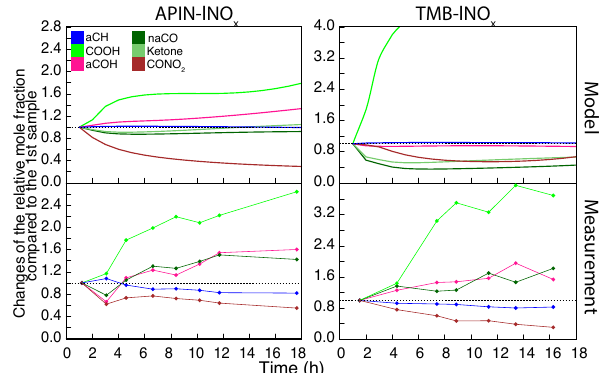
Figure 2. Comparison of the changes of the relative mole frac- tion compared to the first sample for COOH, COH, CO, aCH, and CONO 2 of the aerosol phase measured by Sax et al. (2005) and modeled in this work for APIN-lNO x and TMB-lNO x . For a cho- sen FG, the changes of the relative mole fraction compared to the first sample are calculated as the ratio between the relative mole fraction at the chosen time and the relative mole fraction at 1h. naCO includes ketone and aldehyde FGs, but the change in relative ketone FG abundance is also shown separately for illustration. The contribution of ketone and aldehyde to CO have been reported sep- arately in the model results. The x axis refers to the hours after the lights were turned on in the chamber for the bottom panel (Mea- surement) and the time after the start of the simulation in the top panel (Model). The dashed line corresponds to y = 1 and has been added for visual